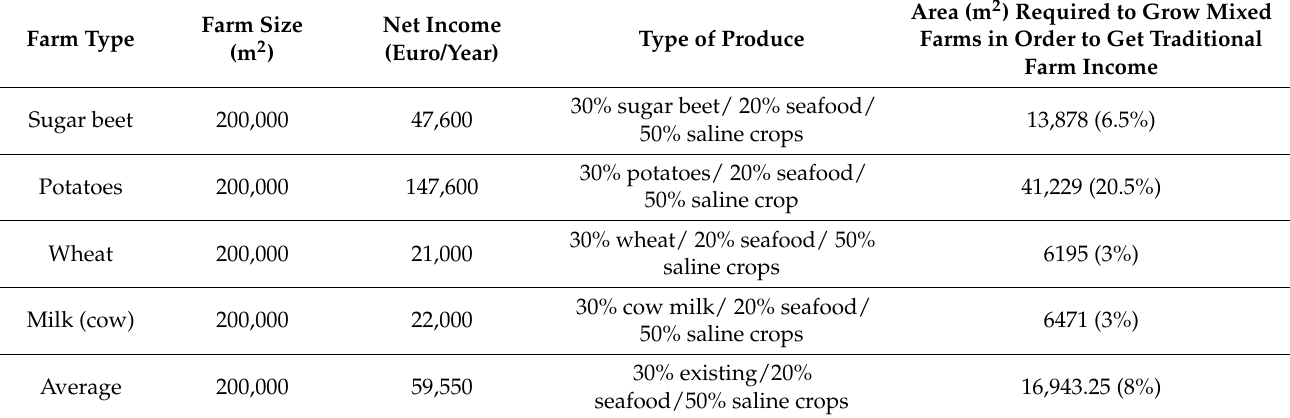
Table 2. Required area (ha) to keep the same income for four traditional crops.